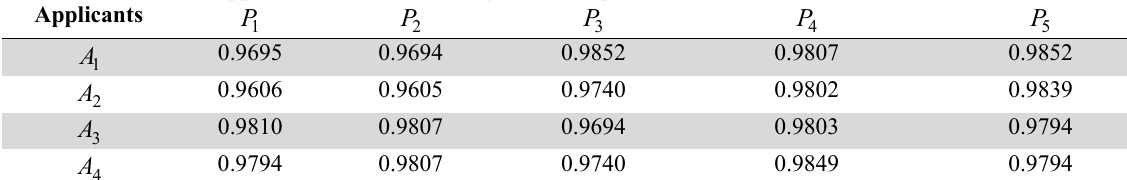
Similarity measure of Applicants vs. Positions using (8) and Type-3 score function